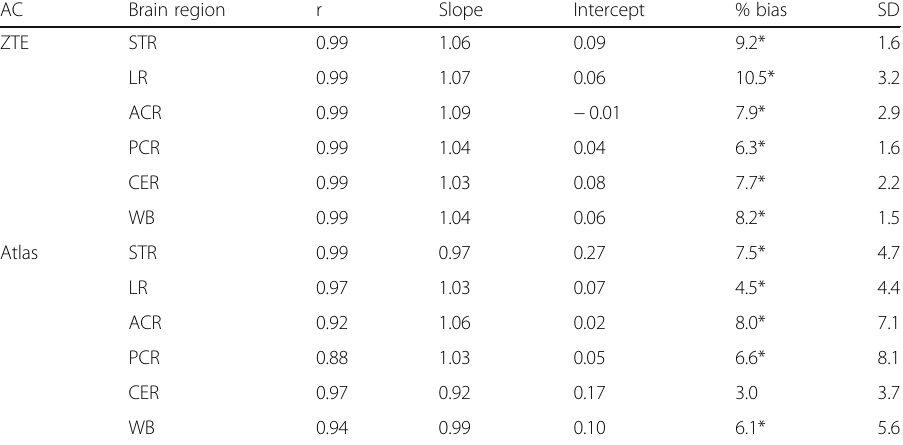
Table 1 Correlation coefficient r , slope and intercept of orthogonal regression across subjects for SUV values in different brain clusters when comparing ZTE- and atlas-attenuation correction (AC) with 68 Ge-AC. In addition, mean bias (%) and accuracy (SD of % bias) are given AC Brain region r Slope Intercept % bias SD ZTE STR 0.99 1.06 0.09 9.2* 1.6 LR 0.99 1.07 0.06 ACR 0.99 1.09 PCR 0.99 CER 0.99 1.03 WB 0.99 1.04 0.06 8.2* 1.5 Atlas STR 0.99 0.97 0.27 LR 0.97 ACR 0.92 PCR 0.88 CER 0.97 0.92 WB